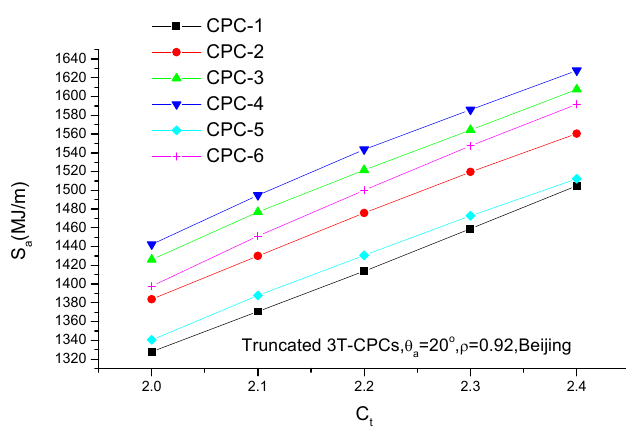
Figure 14. Effects of geometric concentration on S a of truncated 3T ‐ CPCs.